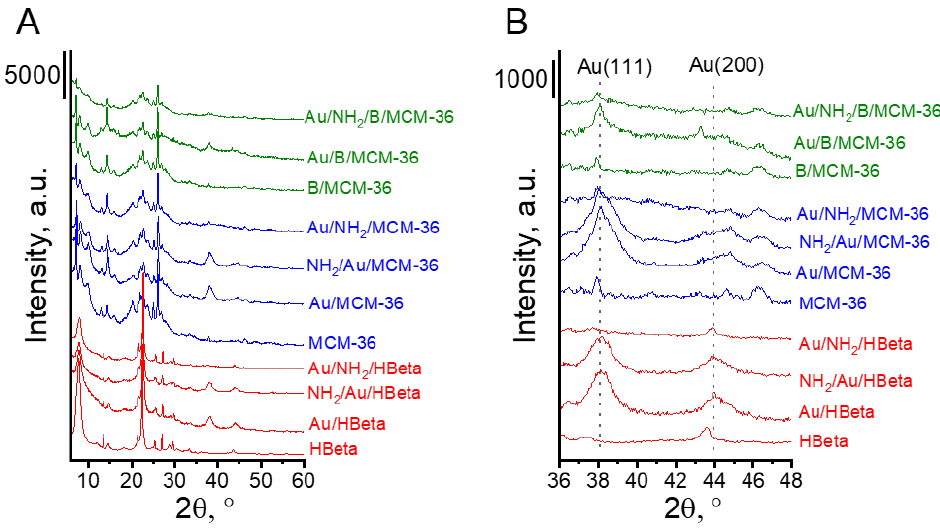
Figure 1. XRD patterns of investigated catalysts. ( A ) The range of 6 – 60° 2 θ ; ( B ) the range of XRD peaks typical of Au(111) and Au(200) planes.